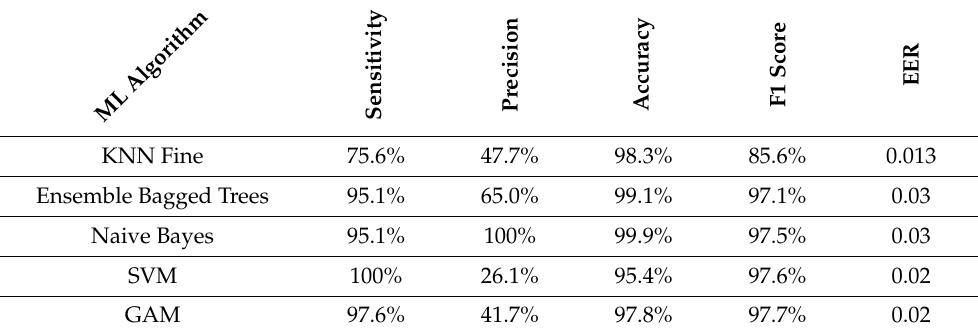
Table 3. ECG Result